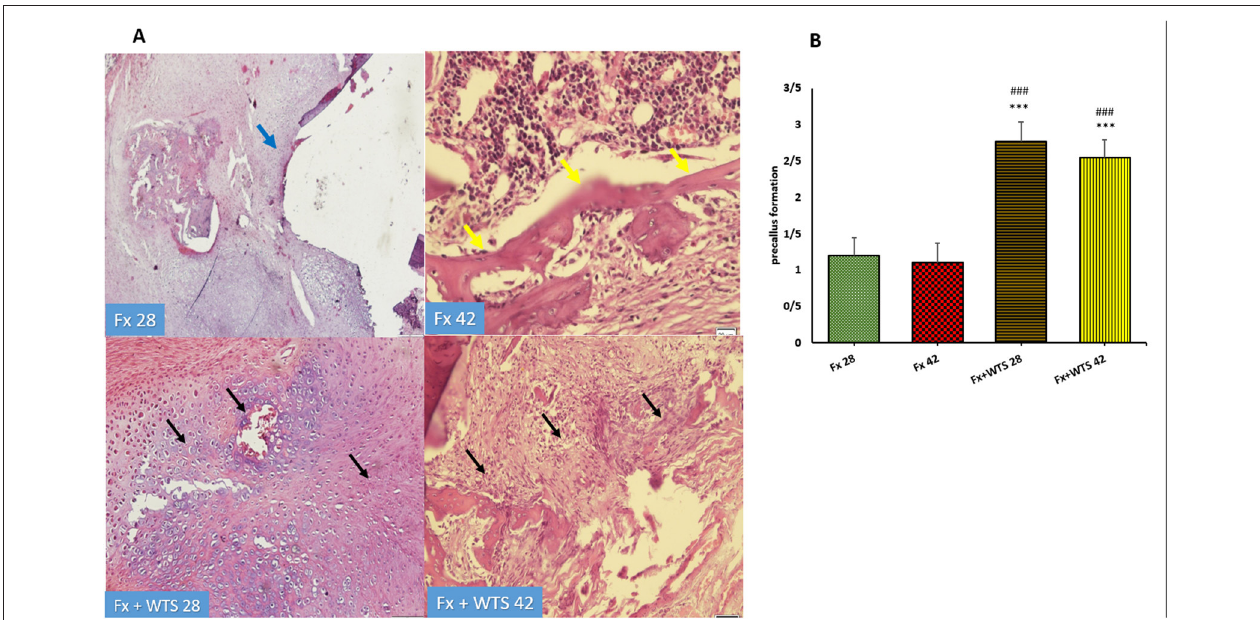
FIGURE 9 | (A) Pathological representation of precallus formation. The Fx 28 group does not show precallus tissue, and the conversion of precallus to callus and regular bone is observed (blue arrow). In the Fx 42 group, bone callus formation and a regular osteoblastic rim forming callus can be seen (yellow arrows). The Fx + WTS 28 group indicates the beginning of the healing process and the beginning of bone and precallus tissue repair (black arrow). In the Fx + WTS 42 group, the precallus remnant and fibrotic non-union are observed (black arrow). (B) The quantification of pathologic findings regarding precallus formation in experimental groups. Fx 28: group subjected to room air for 28 days after surgery and a femoral bone fracture, Fx 42: group subjected to room air for 42 days after surgery and a femoral bone fracture, Fx + WTS 28: group subjected to WTS for 28 days after surgery and a femoral bone fracture, Fx + WTS 42: group subjected to WTS for 42 days after surgery and a femoral bone fracture. The results are presented as mean ± SEM, n = 10. *** P < 0.001 vs. Fx 28; ### P < 0.001 vs. Fx